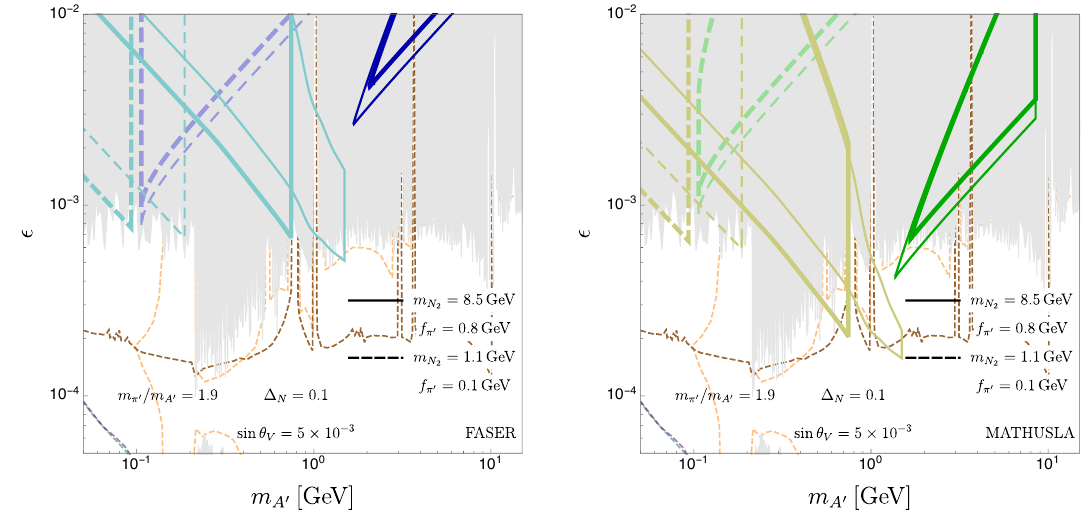
Figure 10 . Sensitivity plots for the dark nucleon and dark pion searches at LHC lifetime frontier, including variation of multiplicity of long-lived particles: FASER (left) and MATHUSLA (right). The dark nucleon searches: FASER (blue solid-lines for m = 8 . 5 GeV , blue dashed-lines for N 2 = 1 . 1 GeV ) and MATHUSLA (green solid-lines for m = 8 . 5 GeV , green dashed-lines for m N N 2 2 = 1 . 1 GeV ). We take different parameters for dark nucleons from figure 4 in order that the m N 2 FASER sensitivity lines appear even for m = 8 . 5 GeV : sin θ = 5 × 10 − 3 and ∆ = 0 . 1 . The dark N 2 V N pion searches: FASER (cyan solid-lines for f = 0 . 8 GeV , cyan dashed-lines for f = 0 . 1 GeV ) and π 0 π 0 MATHUSLA (yellow solid-lines for f = 0 . 8 GeV , yellow dashed-lines for f = 0 . 1 GeV ). The thick π 0 π 0 lines are the same as shown in figures 4 and 5 with a different choice of sin θ and ∆ , while the V N corresponding thin lines show the sensitivity curves when the multiplicities of hadrons are similar, in particular n = 0 . 1 and n = 0 . 2 . For the latter case, the dark pion sensitivities extend to N 1 π 0 3 m since the multiplicity is below unity. As in figures 4 and 5, we also show the existence π 0 < m N 2 constraints and the future sensitivities to the visible dark photon decay (the top and left-bottom shaded areas and the future sensitivity curves from Belle-II, LHCb, SHiP, and